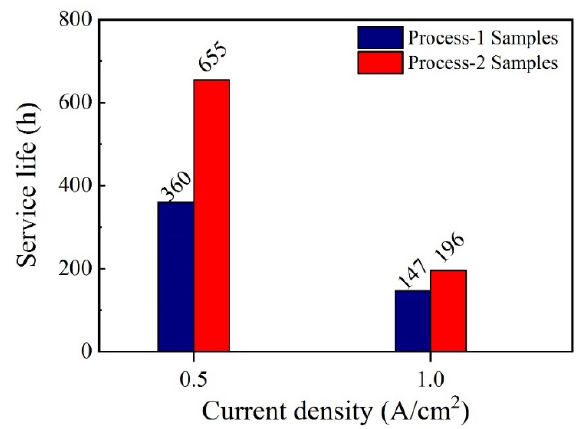
Figure 9. The ALT life of the Ti / BDD coated electrodes prepared by the two processes at di ff erent current densities in electrolysis. 261